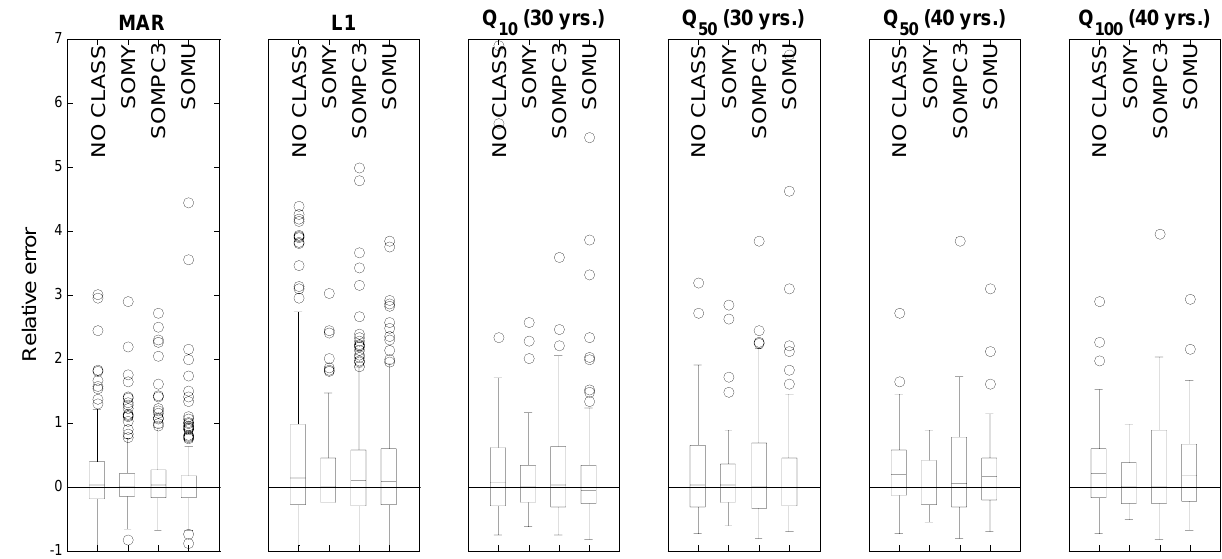
Fig. 9. Distribution of relative errors in terms of 25th, 50th and 75th percentiles, maximum and minimum values, and outliers (circles).